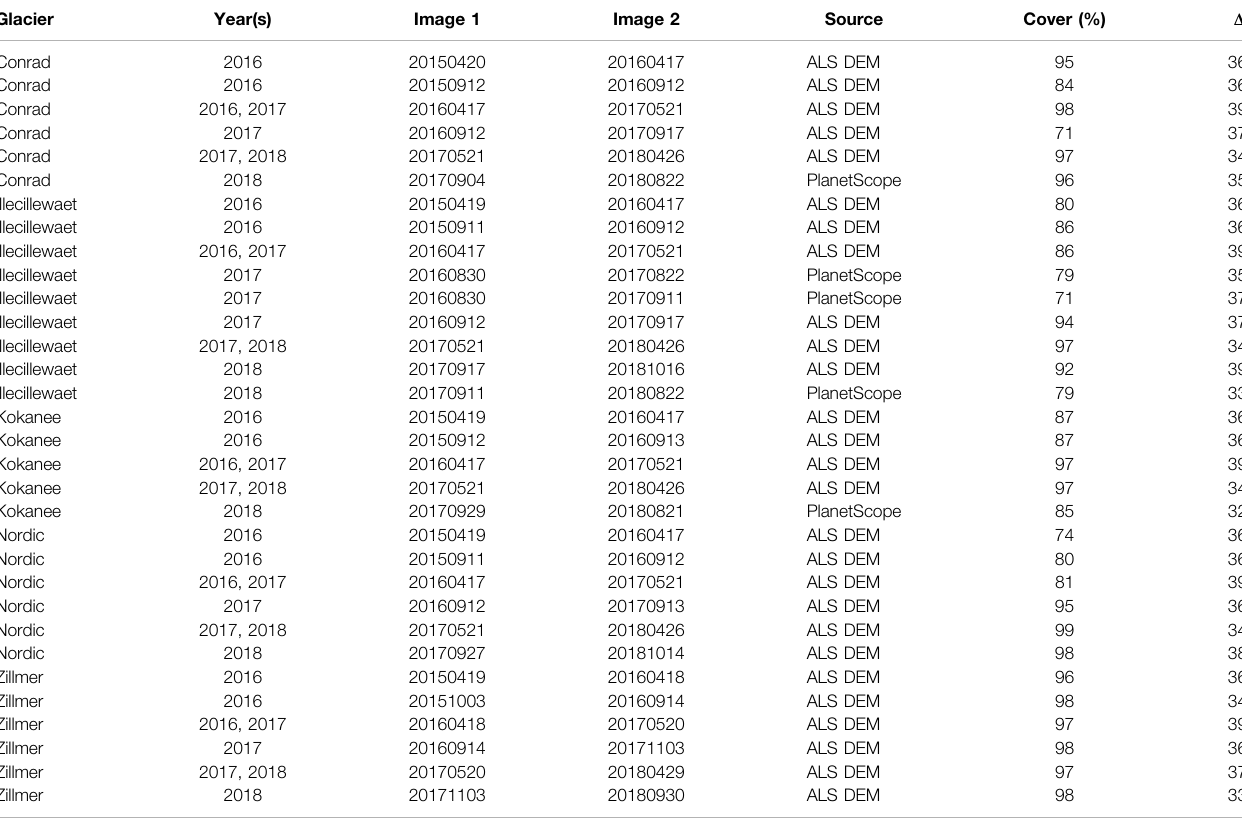
TABLE 2 | Acquisition dates, sources and coverage of individual velocity fi elds. Year(s) documents which annual velocity mosaics the velocity fi elds contribute to. Δ t represents the time (days) between image or DEM pairs. Glacier Year(s) Image